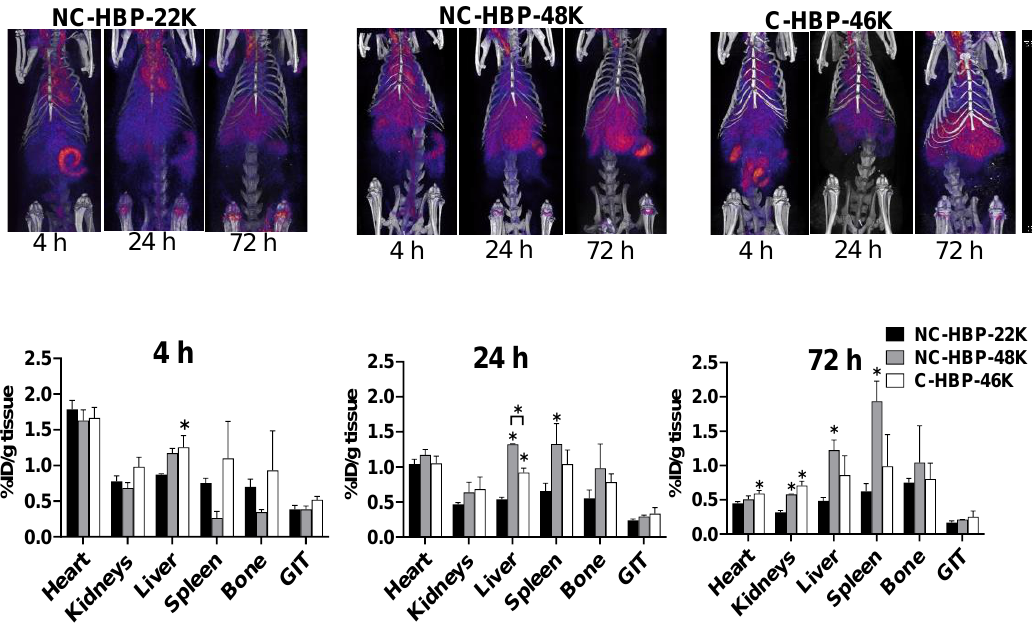
Figure 5. Representative PET/CT images of 89 Zr-labelled HBPs acquired at 4 h, 24 h and 72 h post- injection for each HBP (top panels) and estimated Comparative biodistribution of HBPs at a various time interval in different organs (bottom panels). Region of interest (ROI) analysis of whole body and organs allow determination of in vivo distribution of HBPs in the organs. Biodistribution across organs at various timepoints were calculated by ROI analysis of PET/CT images. Images are decay corrected to the point of dosing and intensity in each organ is expressed as % injected dose/g of tissue ( n = 3 rats for all groups except NC-HBP-48K, where n = 2 rats and data are represented as mean ± range). Statistical significance was conducted using one-way ANOVA followed by Tukey’s test. * indicates p < 0.05 compared with NC-HBP-22K. ID: Injected dose.